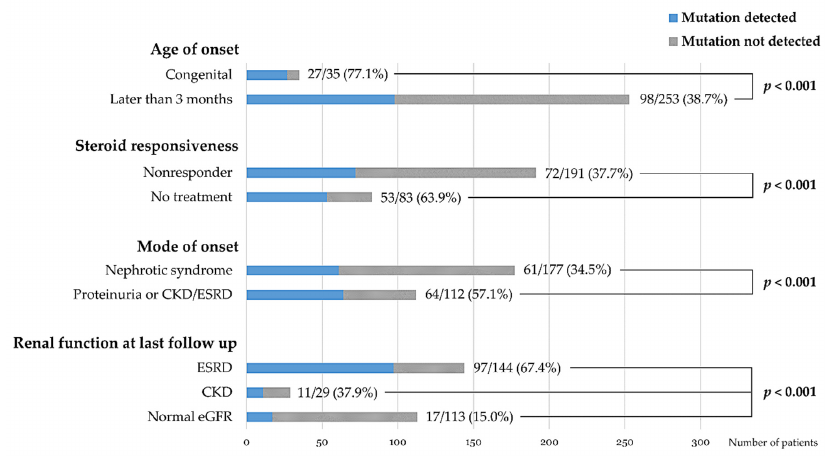
Figure 1. Comparison of mutation detection rates among subgroups of patients according to onset age, steroid responsiveness, mode of onset, and renal functional outcome.